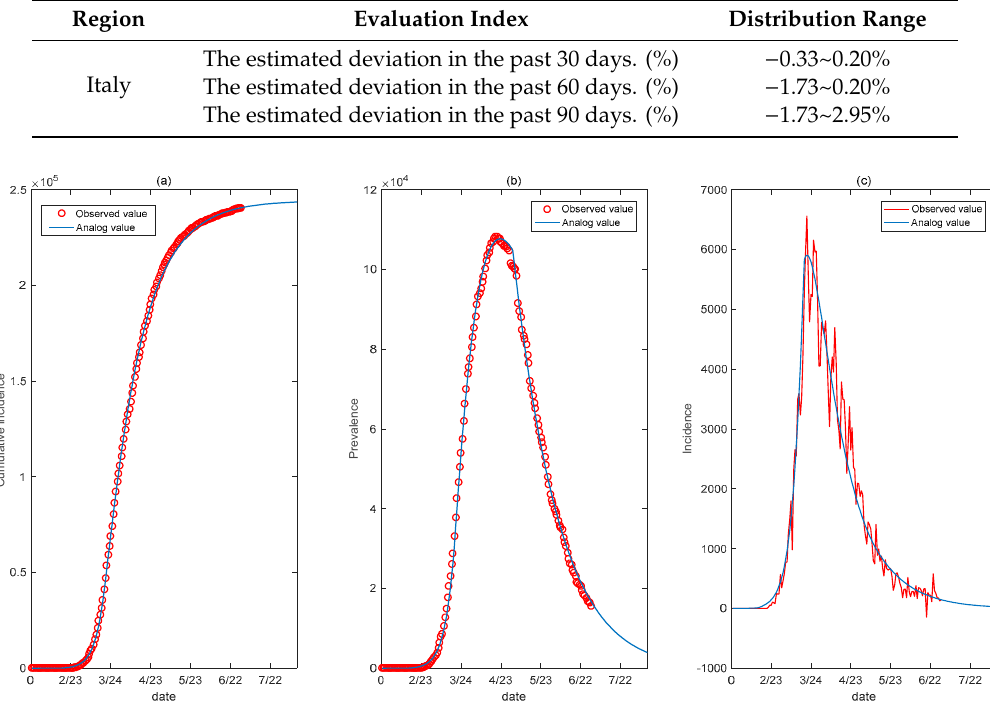
Figure 5. Simulation of epidemic-situation development trend. Simulation of the epidemic spread in Italy. Fitting curves: cumulative incidence ( a ), prevalence ( b ), incidence ( c